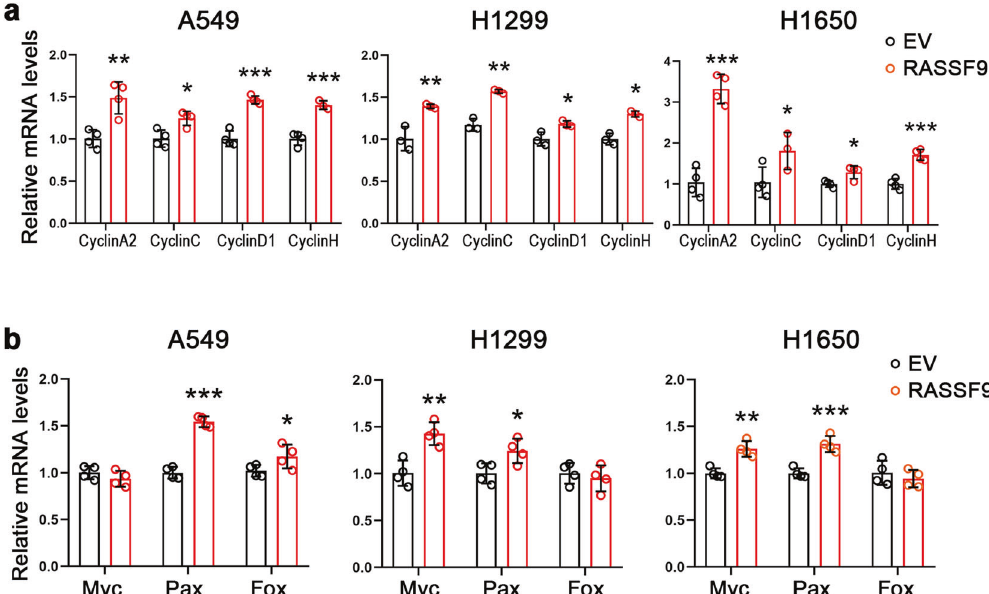
Fig. 2 RASSF9 increases the expression of cyclins and oncogenes. a Elevated expression of RASSF9 increases the mRNA levels of cyclins in A549, H1299, and H1650 cells. b Effects of RASSF9 on the expression of c-Myc , Pax , and Fos . Cells were transfected with the plasmid expressing Rassf9 . Control cells were transfected with the empty vector pcDNA3.1 (EV). Twenty-four hours post-transfection, total RNA was extracted for gene expression analysis by qRT-PCR, and GAPDH was used as a house-keeping gene. Data are presented as means ± SD (error bars). * P < 0.05, ** P < 0.01, and *** P < 0.001. Student ’ s t